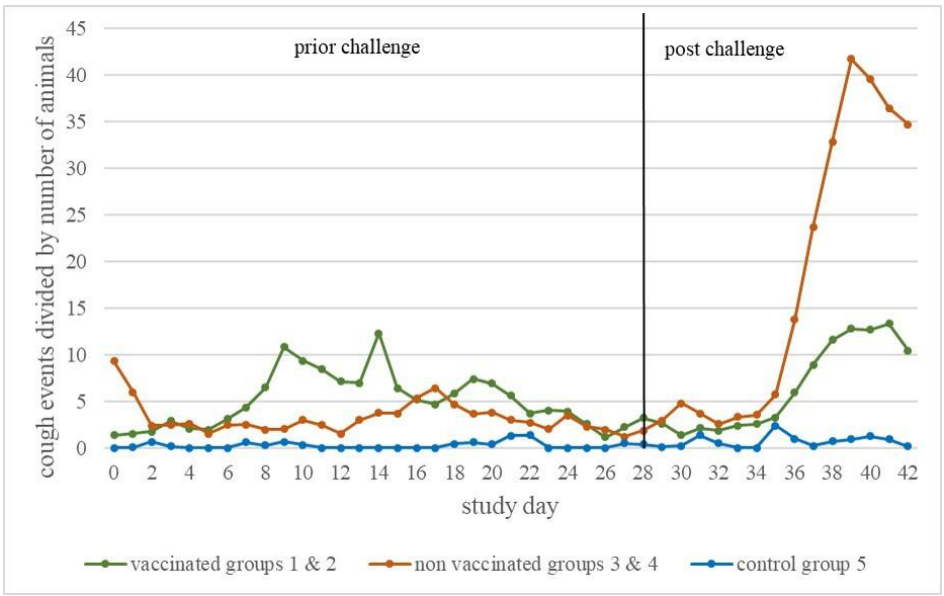
Figure 3. Cough monitor results. Cough events divided by the number of animals in each room (vaccinated, infected (groups 1 and 2), non-vaccinated, infected (groups 3 and 4), and vaccinated control (group 5) animals) per study day from study day 0 to study day 42.